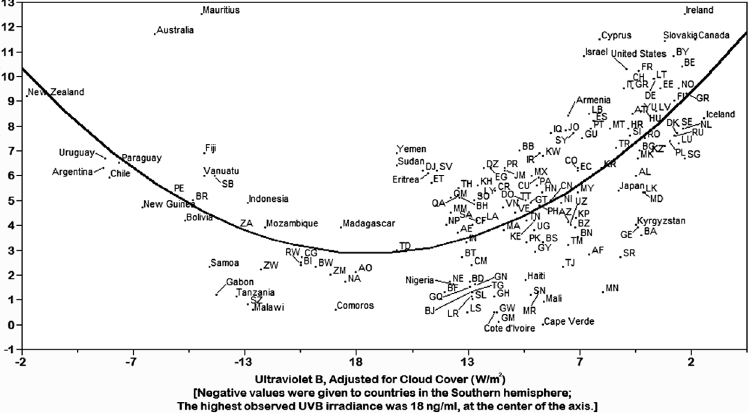
Fig 1. Rates of age-standardized leukemia incidence (cases per 100,000) in males according to cloud cover-adjusted UVB irradiance (W/m 2 ), 172 countries, 2012.